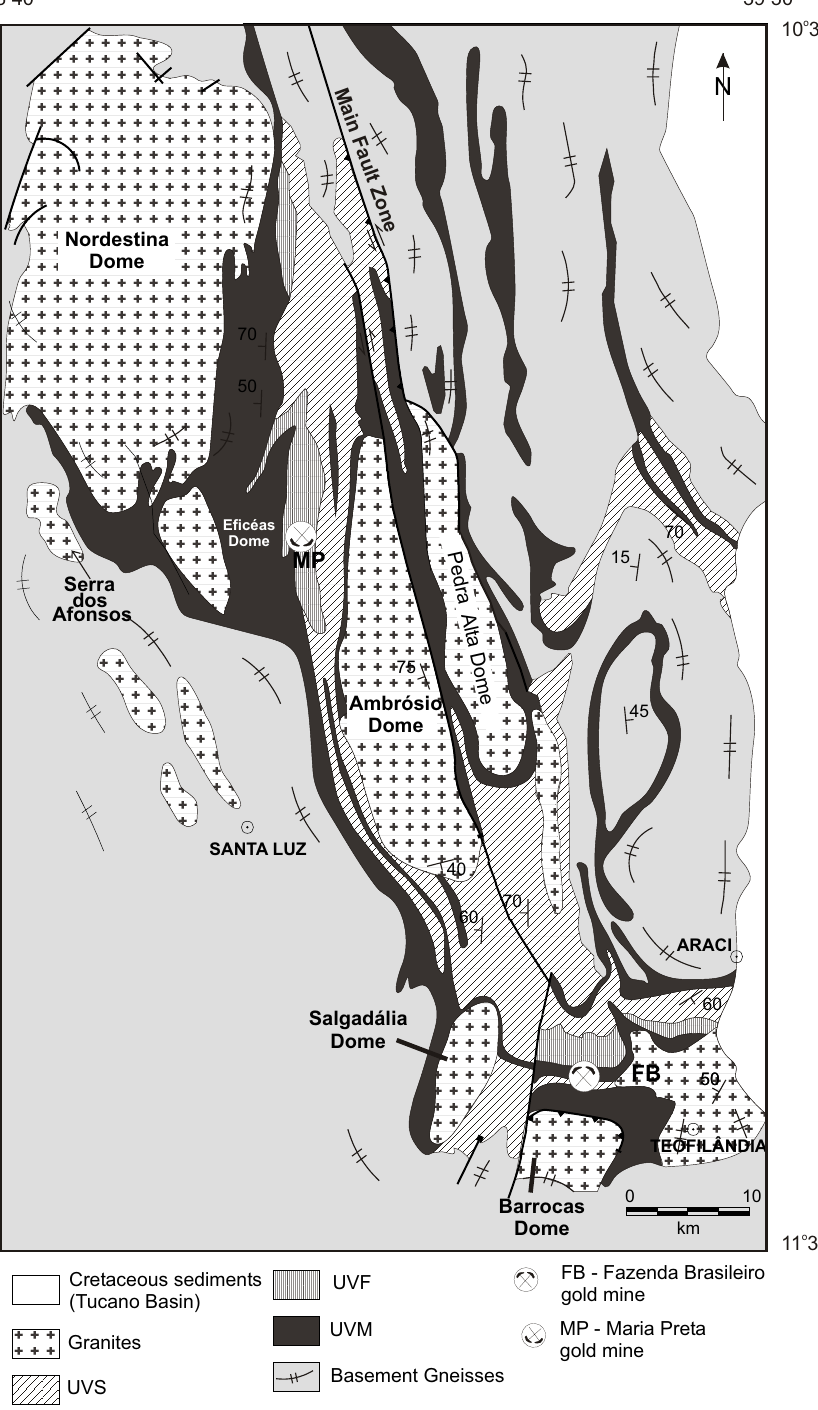
Fig. 2 – Geological map of the Rio Itapicuru Greenstone Belt showing the location of the Fazenda Brasileiro gold mine (after Silva et al. 2001b). UVS-Volcano-sedimentary unit, UVF – Felsic volcanic unit, UVM – Mafic volcanic unit.